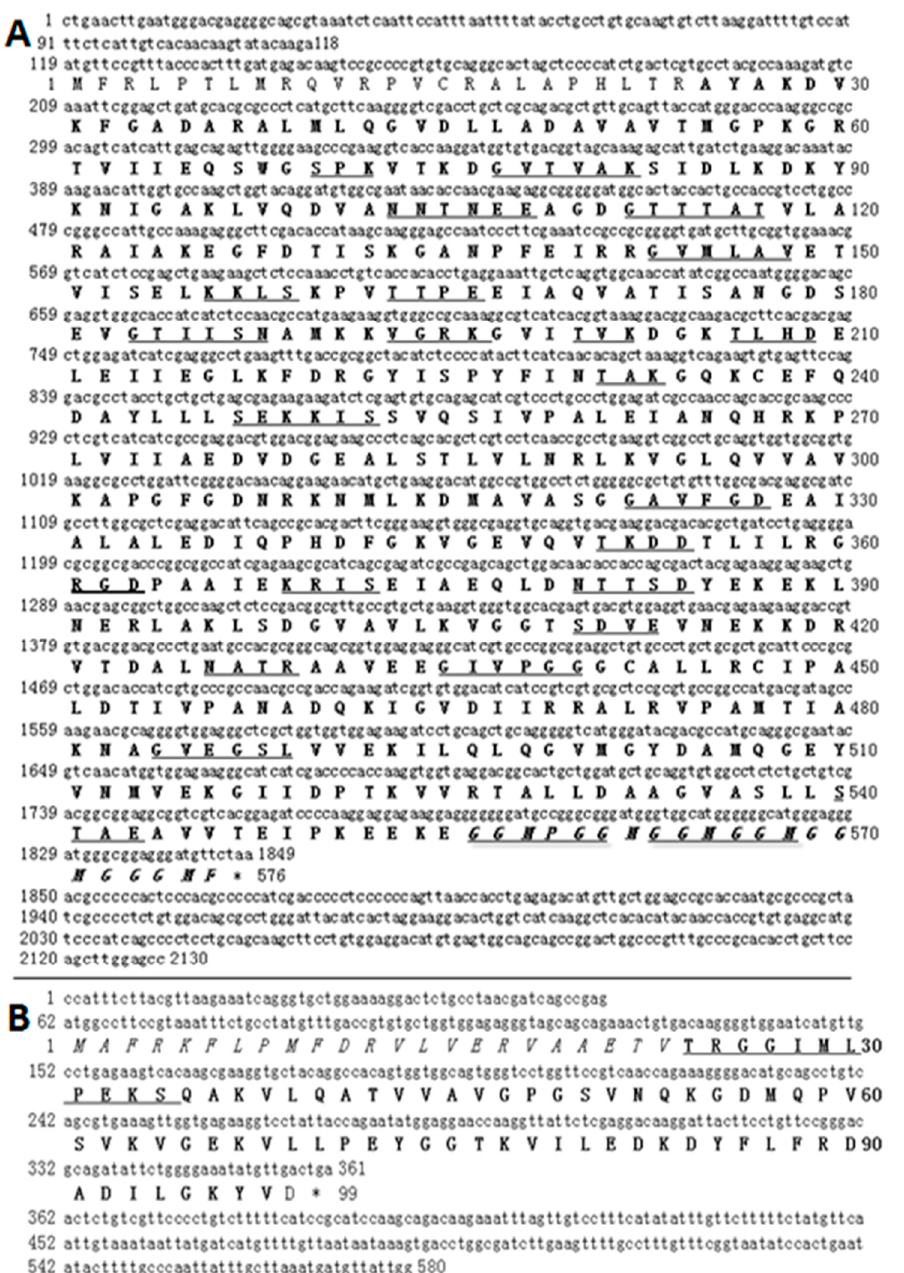
Figure 1. Nucleotide and deduced amino acid sequences of Cn-HSP60 and Cn-HSP10.The deduced amino acid sequence is shown upon the nucleotide sequence. The termination codon is marked by an asterisk. ( A ) is shown the Cn-HSP60: RGD Cell attachment sequence is shown in bold line. The conserved domain (26-571 aa, 60 kDa chaperonin (groEL) ) is in bold (Cpn60); Amidation site